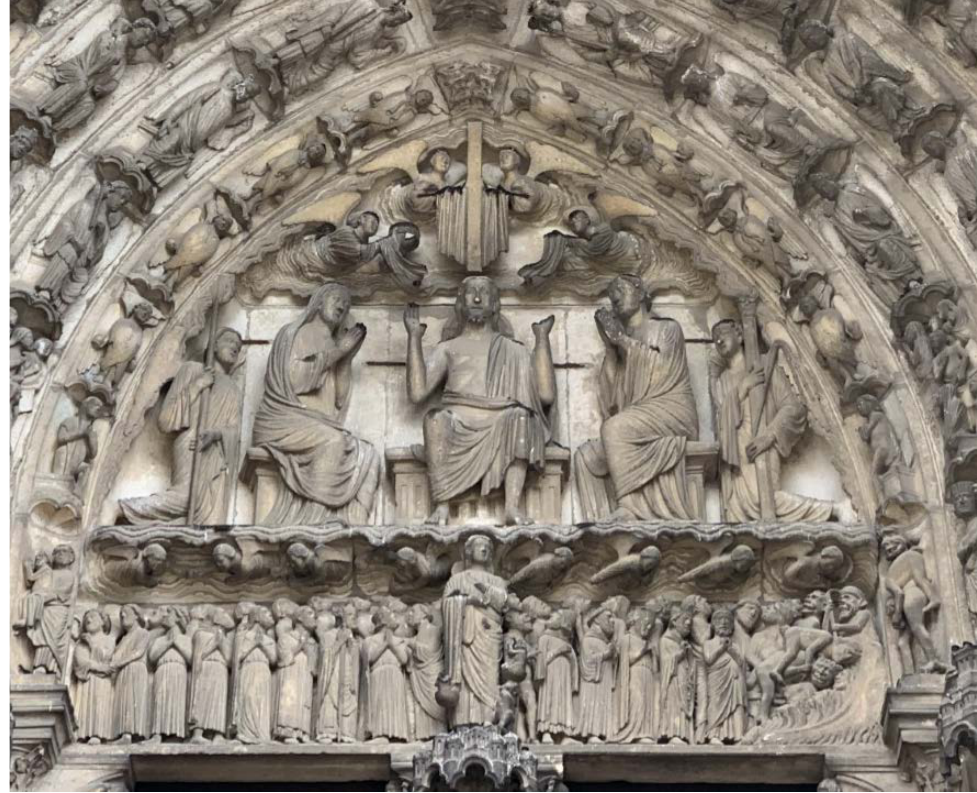
Figure 1. Tympanum of the central bay of south porch of Chartres Cathedral, c.1220–30.